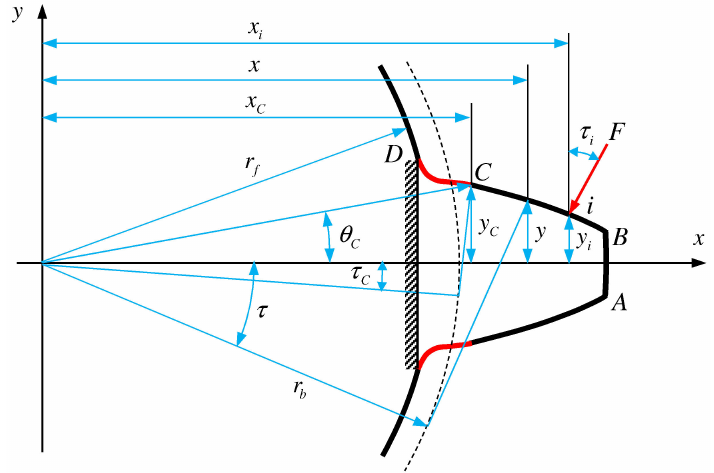
Figure 2. Geometrical profile and force diagram of the involute spur